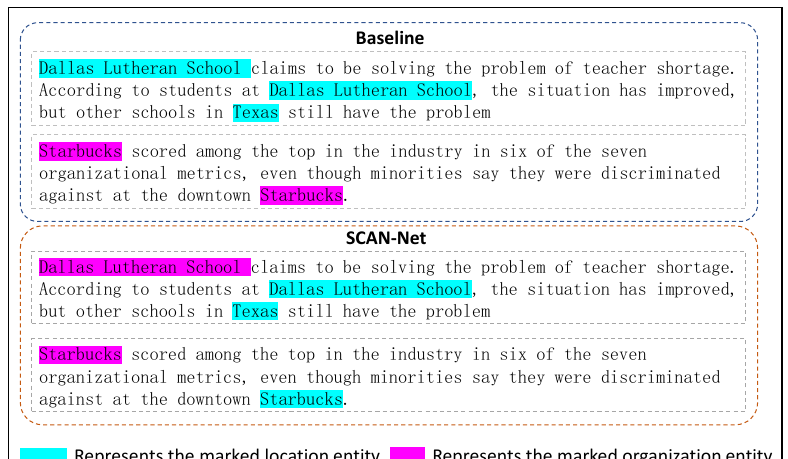
Figure 5. Case study of SCAN-Net